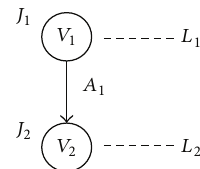
Figure 1: A simple ETG with two